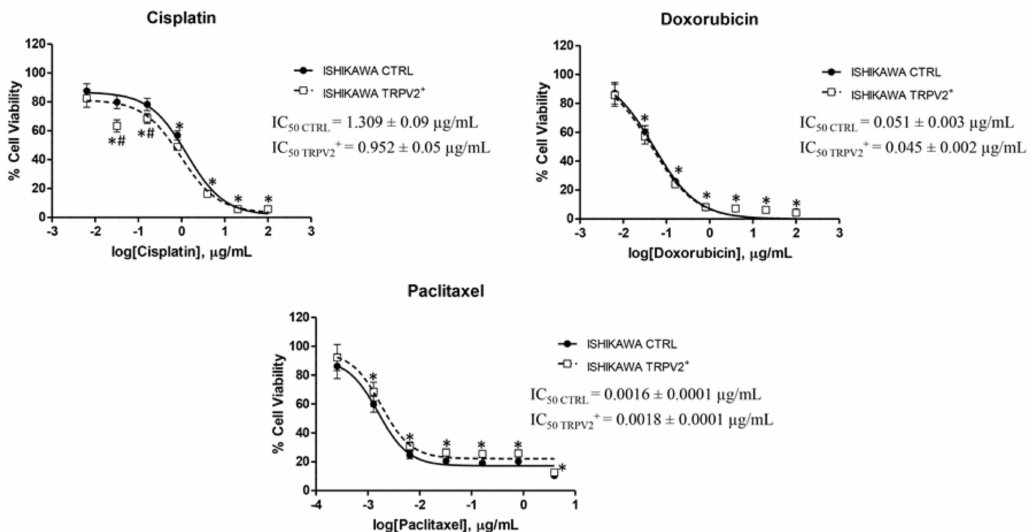
Figure 7. TRPV2 over-expression enhanced CIS sensitivity. Untransfected and TRPV2 + cells were treated for 72 h with di ff erent concentrations of CIS, DOX (up to 100 µ g / mL) and PAC (up to 4 µ g / mL). Data shown are expressed as mean ± SD of three separate experiments. * p < 0.05 treated vs. vehicle, # p < 0.05 TRPV2 + vs.